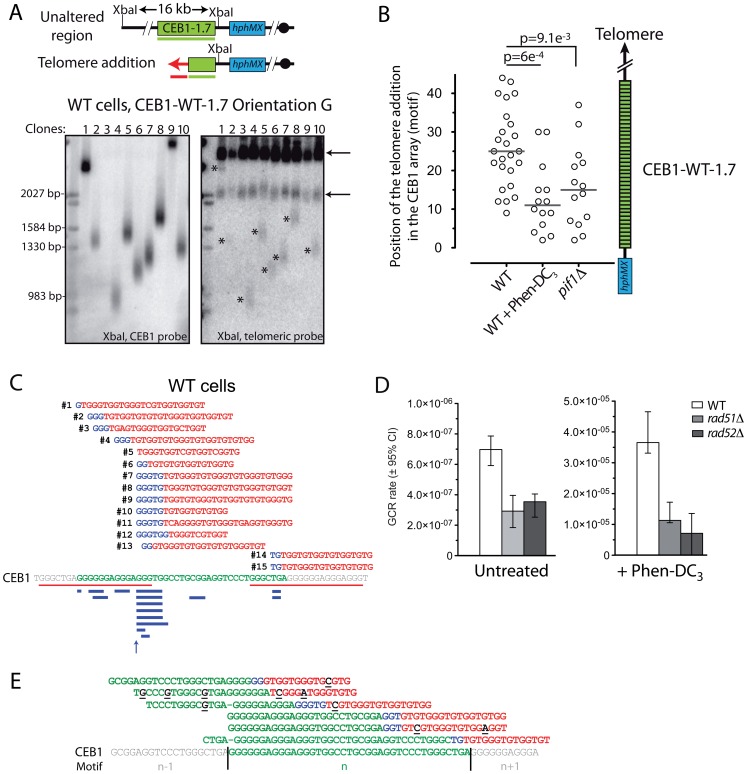
GCR are mainly telomere additions in CEB1.(A) The top panel schematically represents the genomic region surrounding CEB1 with the XbaI restriction site and the CEB1 (green) and TG1–3 (red) probes used to study rearrangements of the region. The size of the unaltered region upon digestion is indicated. Upon telomere addition, digestion with XbaI is expected to produce a fragment that can be hybridized by both the CEB1 and the telomeric (TG1–3) probe. The bottom panels show the rearrangements present in independent 5FOA/Can-resistant colonies obtained from WT cells bearing CEB1-WT-1.7 in the orientation G (ORT6542-6). Stars indicate smears hybridizing both the CEB1 and the telomeric probes (Orientation G lanes 1,2,4,5,6,7,8,10). Arrows indicate endogenous telomeres. Ambiguities remained for CEB1 smears co-migrating with endogenous telomeres (clone 9). One lane shows no CEB1 signal (clone 3). (B) Distribution of the telomere addition positions within CEB1-WT-1.7 estimated from the mean molecular weight determined by Southern blot (see Materials and Methods) in untreated and Phen-DC3-treated WT cells (ORT6542-6), and pif1Δ cells (ORT6543-1). Grey bars show the median of the distributions. Distributions were compared using a non-parametric test (Mann-Whitney-Wilcoxon). (C) Analysis of the CEB1-telomere junctions in WT cells (ORT6542-6). Each CEB1-telomere junctions have been obtained from 15 independent 5FOA/Can-resistant colonies. The sequences are oriented 5′-3′. The template CEB1 motif is shown in green, and the flanking motifs (n−1 and n+1) are shown in grey. The G-quadruplex forming motifs are underlined in red. Nucleotides shared by both the CEB1 and the telomeric sequences at the junction are in blue. The telomeric sequence is in red. The CEB1 sequence above the junctions is identical to the CEB1 reference, and is not shown for each molecule. A schematic representation of the length of shared nucleotides between the CEB1 and the telomeric sequences is shown in blue below the reference CEB1 motif. An arrow indicates the junction in which no nucleotide is shared. (D) GCR rates in WT (ORT6542-6), rad51Δ (ORT7189), and rad52Δ (ORT7310-2) cells bearing CEB1-WT-1.7 upon treatment (right) or not (left) with Phen-DC3 at 10 µM. The scale is linear. (E) Analysis of the single nucleotide polymorphisms (SNPs) around the CEB1-telomere junctions covered by at least 3 different reads. SNPs present in 100% of the reads are shown in black and underlined. Other legends as in (C).